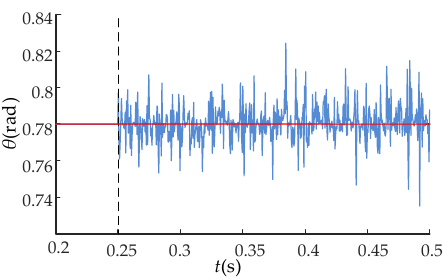
Figure 2. Initial phase waveform under high-frequency random noise conditions.